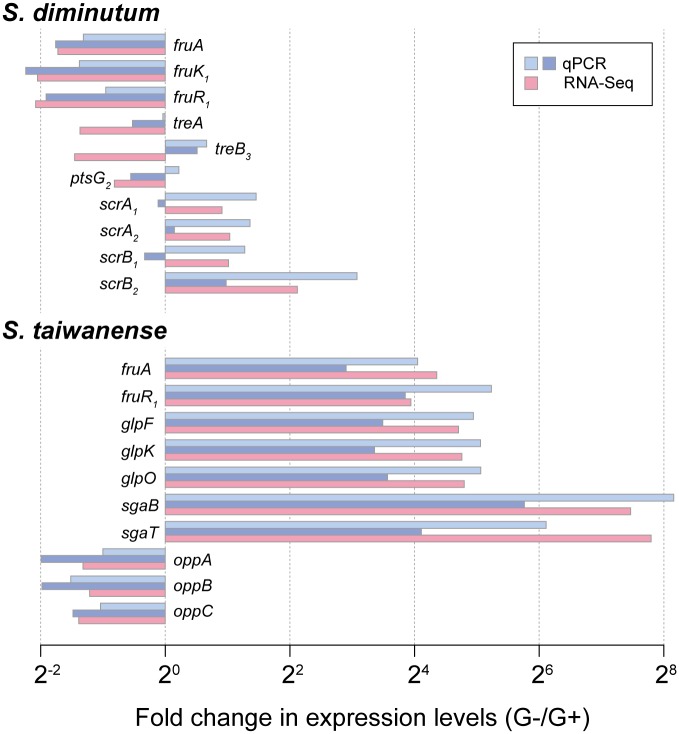
—Validation of differential expression in selected genes. Three biological replicates were collected for this study. The first set was used in the RNA-Seq experiment for the initial identification of differentially expressed genes, the remaining two were used for validation by qRT-PCR.